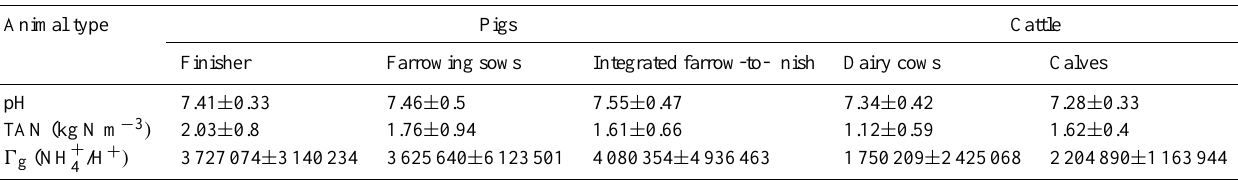
Table 5. Mean and standard deviation of total ammoniacal nitrogen (TAN) content and pH of different slurry types from Provolo and Martinez-Suller (2007) and calculated 0 g values.